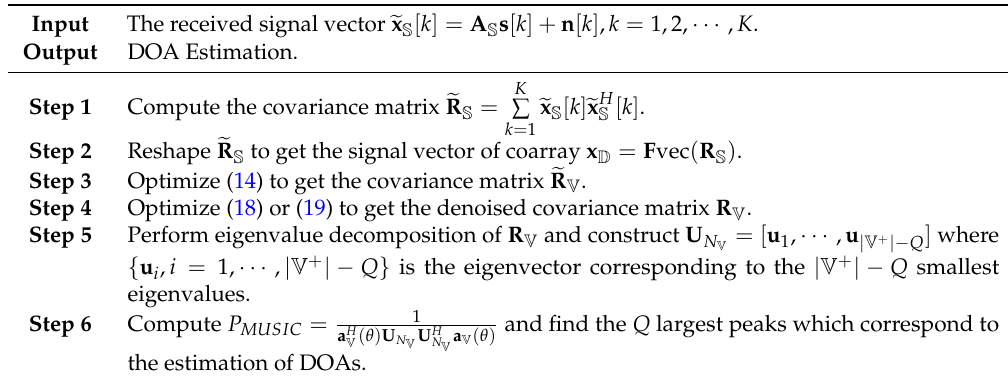
Table 1. A novelty direction of arrival (DOA) estimation approach. MUSIC: multiple signal